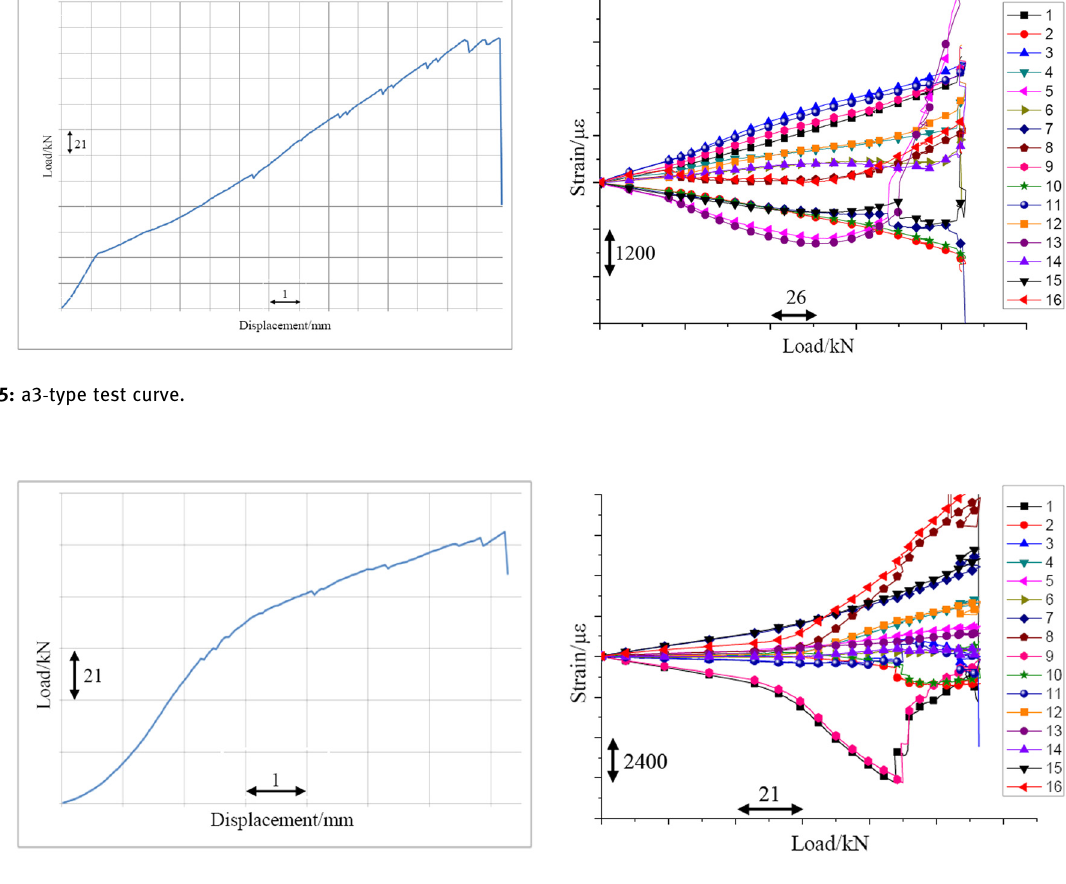
Figure 6: b1 - type test curve.